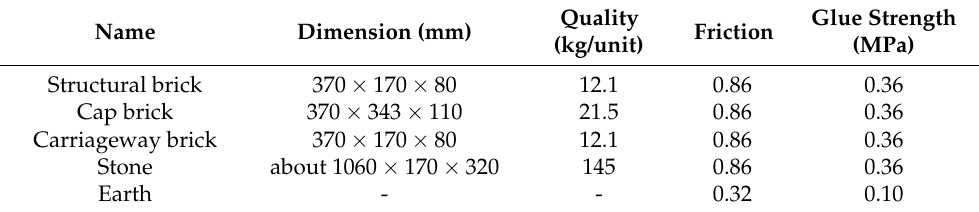
Table 1. Material input